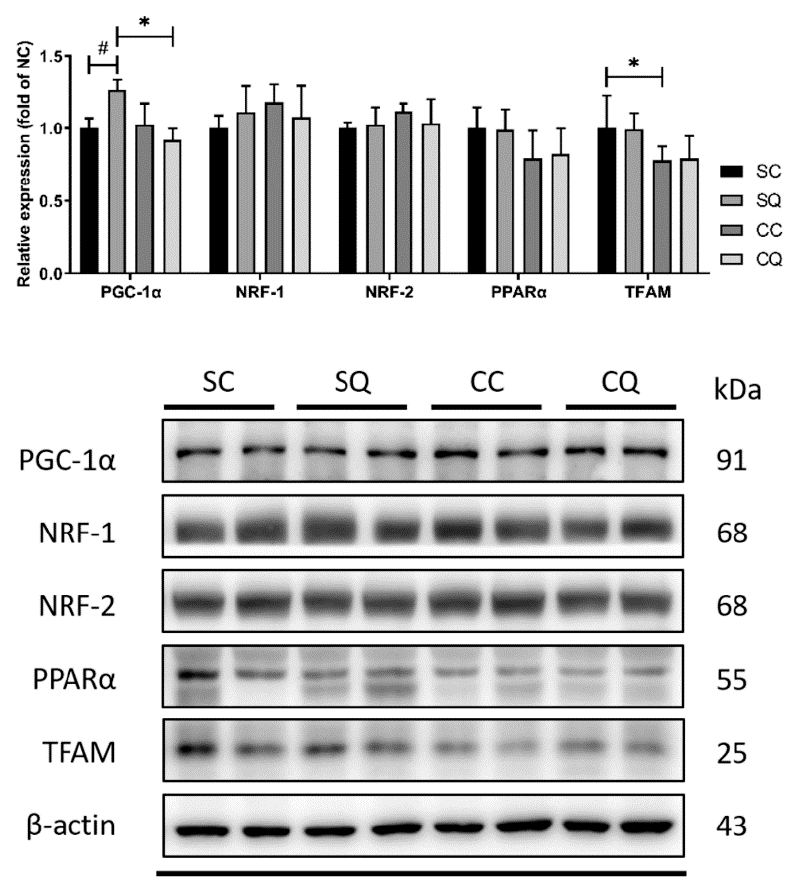
Figure 7. Protein expression of testicular mitochondrial biogenesis markers in sham surgery and CKD surgery mice treated with vehicle (corn oil) or CoQ10. SC: sham surgery mice with vehicle; SQ: sham surgery mice with CoQ10; CC: CKD surgery mice with vehicle; CQ: CKD surgery mice with CoQ10. Data are expressed as the mean ± SD ( n = 4–6 per group). * p < 0.05 denotes a significant difference between the sham surgery and CKD surgery groups (SC vs. CC and SQ vs. CQ); # p < 0.05 denotes a significant difference between the vehicle treatment and CoQ10 treatment groups (SC vs. SQ and CC vs. CQ). CoQ10, coenzyme Q10.